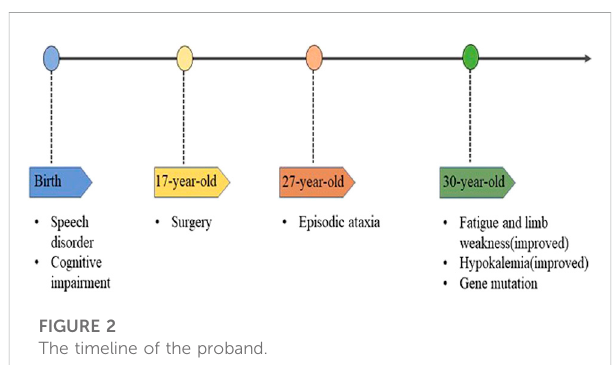
FIGURE 2 The timeline of the